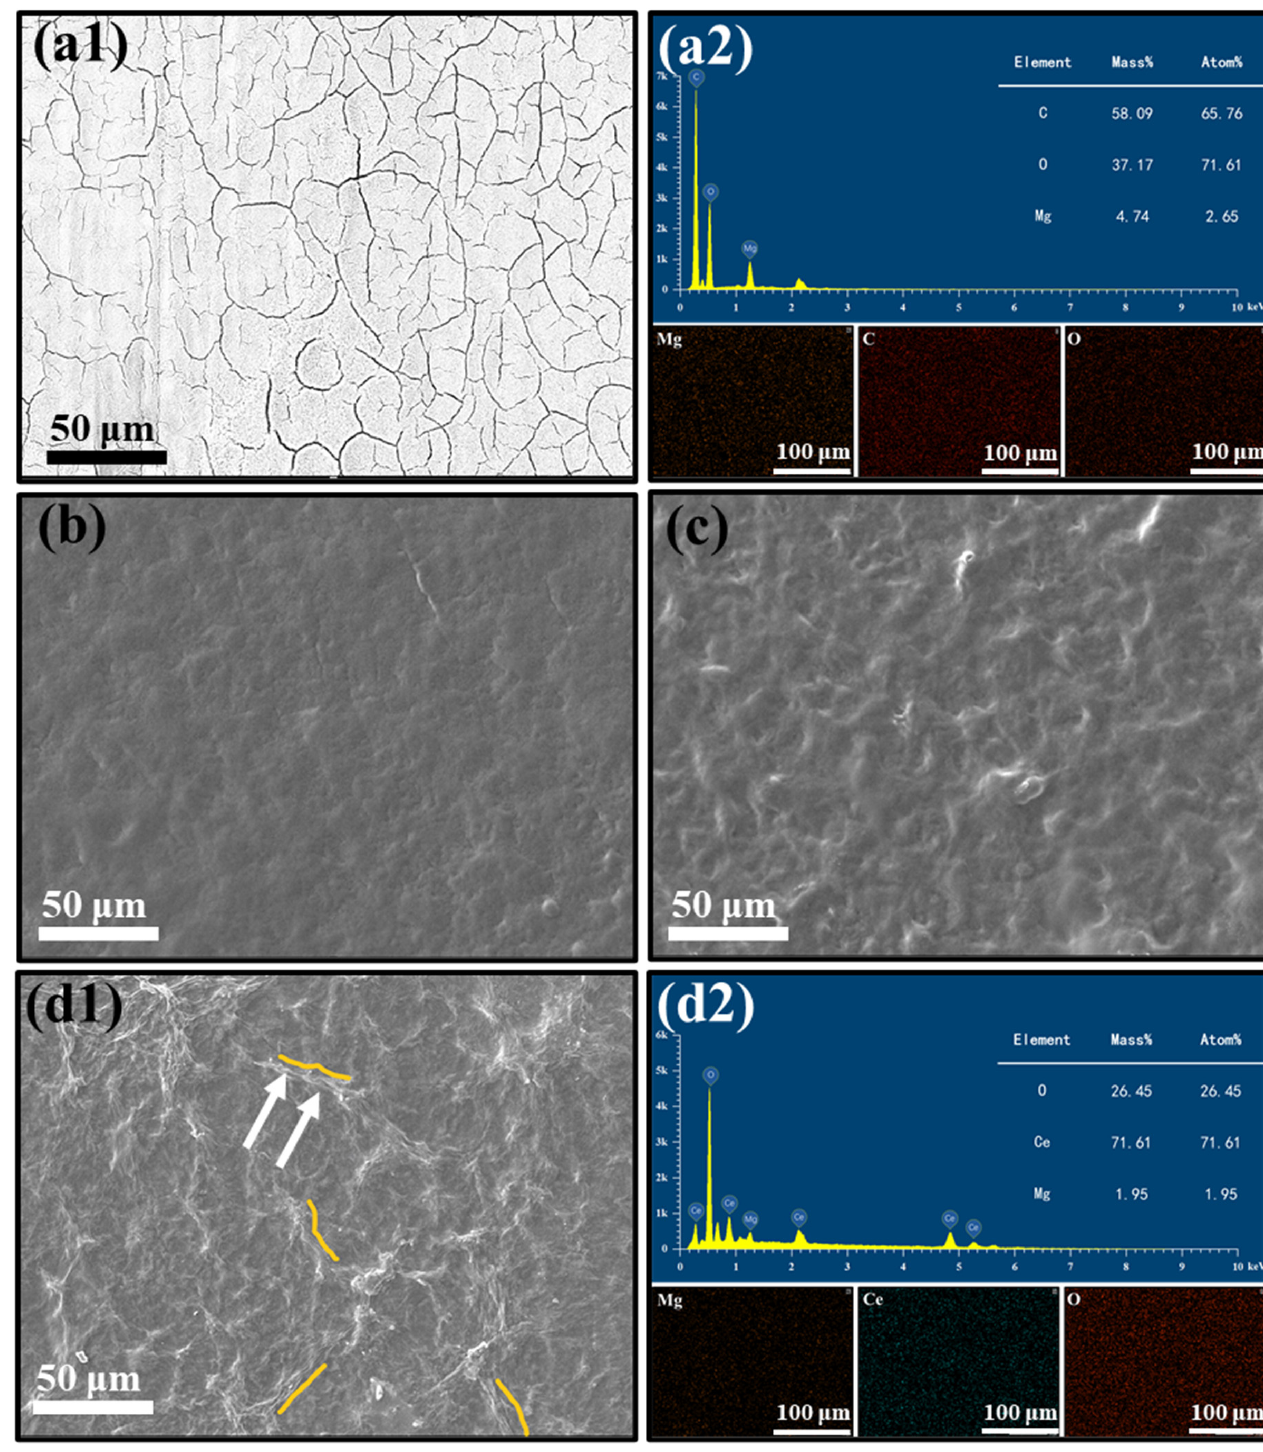
Figure 2. SEM images of the samples under different coatings: ( a1 ) surface morphology of Ce(IV), ( a2 ) EDS pattern of Ce(IV), ( b ) surface morphology of Ce(IV)/PEI/PAA, ( c ) Ce(IV)/PEI-C/PAA, ( d1 ) Ce(IV)/PEI-C/PAA-GO, and ( d2 ) EDS pattern of Ce(IV)/PEI-C/PAA-GO coating.